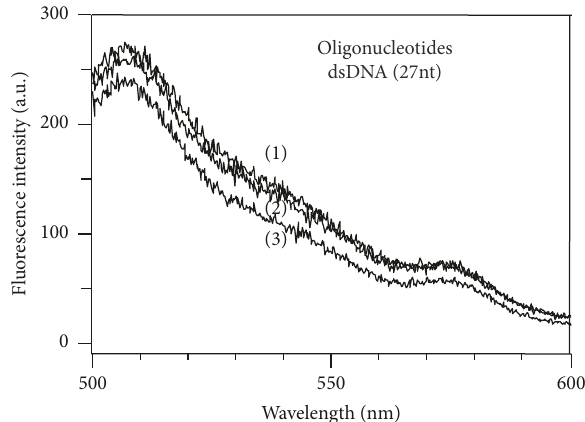
Figure 6: Effect of 𝛼 -PrP concentrations on the emission spectra of YOYO (8 nM) intercalated in 27-mer oligonucleotide (400nM in phosphate). Spectrum (1), fluorescence spectra of the YOYO bound to the oligonucleotide in Hepes buffer, pH 7.4 containing 100mM NaCl in the absence of 𝛼 -PrP; traces (2) and (3) are the fluorescence spectra of the dye after the addition of the protein (final concentrations 0.6 and 1.2 𝜇 M, resp.) to the oligonucleotides. Dye 8 nM and DNA-phosphate 400 nM (ratio 1: 50). Excitation 485 nm. Temperature 20 ∘